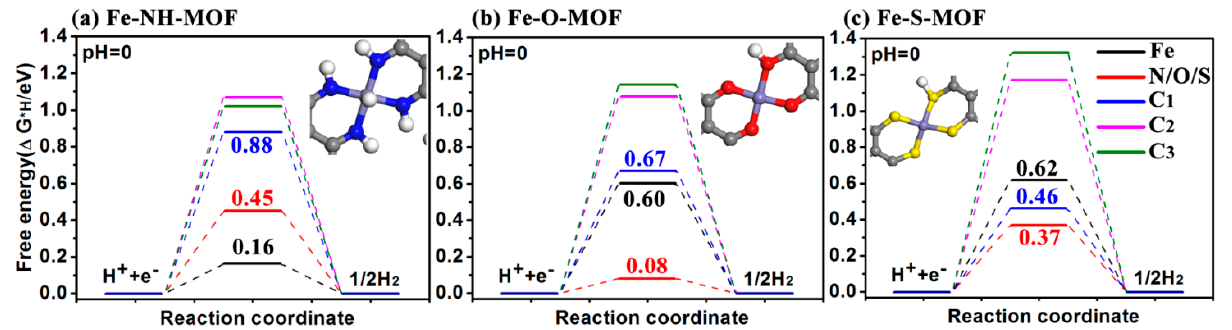
Figure 5. Calculated free energy diagram for hydrogen evolution on ( a ) Fe-NH-MOF, ( b ) Fe-O-MOF, and ( c ) Fe-S-MOF monolayers at a potential U = 0 relative to the standard hydrogen electrode at pH = 0. Insets are corresponding optimized adsorbed H intermediates.